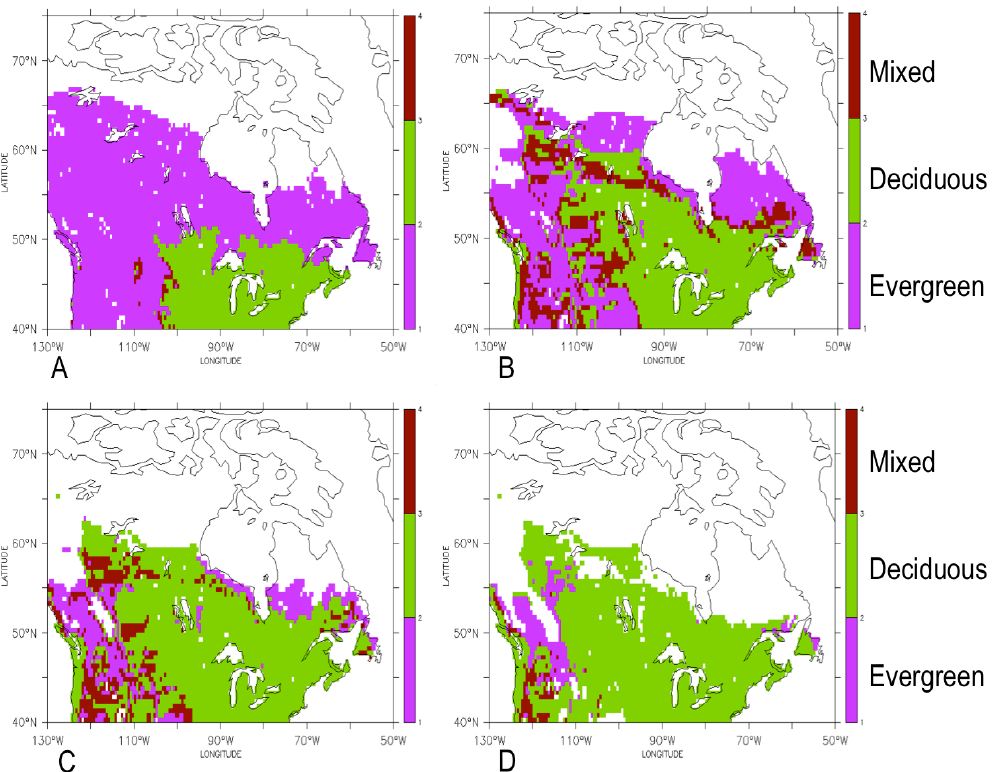
Figure 1. The dominant plant functional types (PFT) distribution ( A ) with current climate and the equilibrium response distribution for ( B ) future climate, ( C ) future climate with disturbance rate doubled, and ( D ) future climate with disturbance rate tripled.